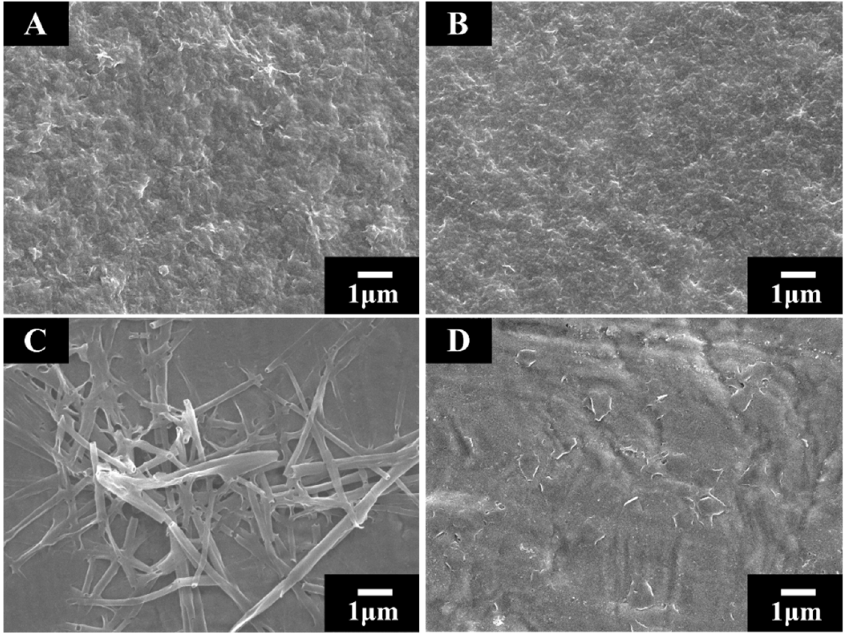
Figure 2. SEM images of films, deposited from 1 g L − 1 CBXNa 2 solutions in water at ( A ) 5 V, ( B ) 15 V and in ethanol-water solvent (5% water) at ( C ) 20 V and ( D ) 80 V.